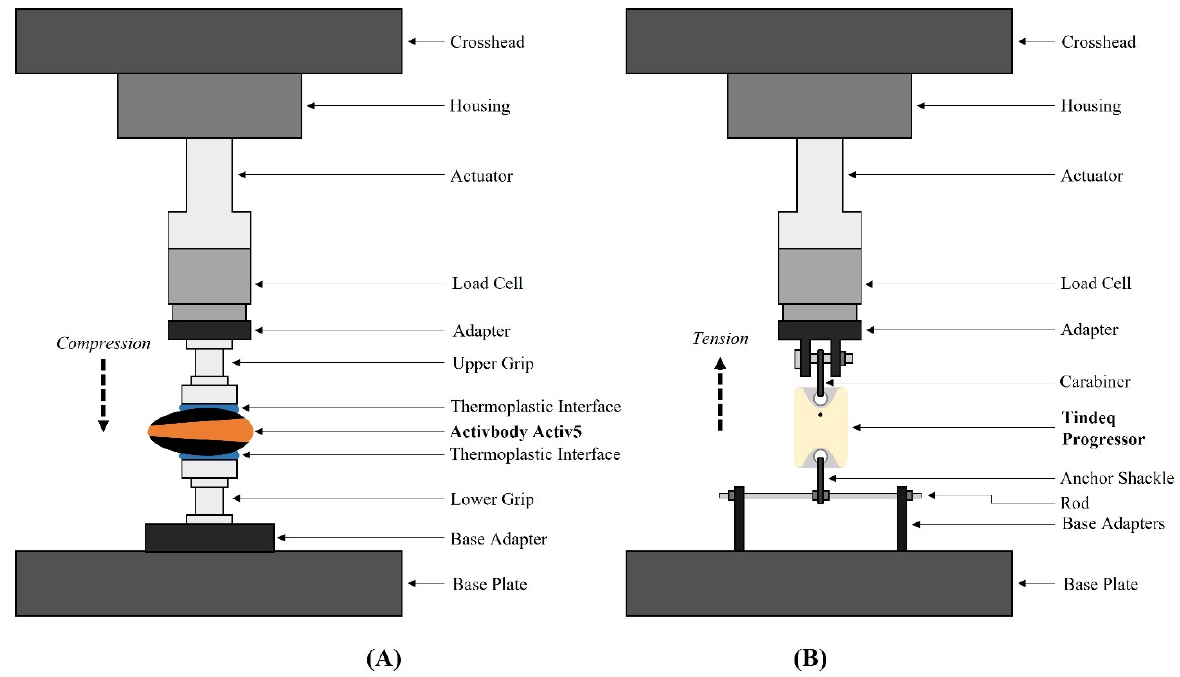
Figure 1. Schematic of the testing set-up using the universal testing machine for loading the ( A ) ActivBody Activ5 in compression; and ( B ) Tindeq Progressor in tension.